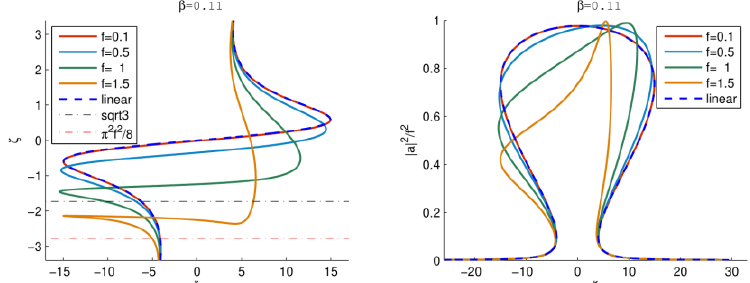
Fig. 1. Tuning (left) and resonance (right) non-linear curves of self-injection locking for different pump amplitudes (continuous lines) along with a curve for linear self-injection locking (dashed line). The boundaries of the soliton generation region (dashed-dotted line) are also plotted in the right